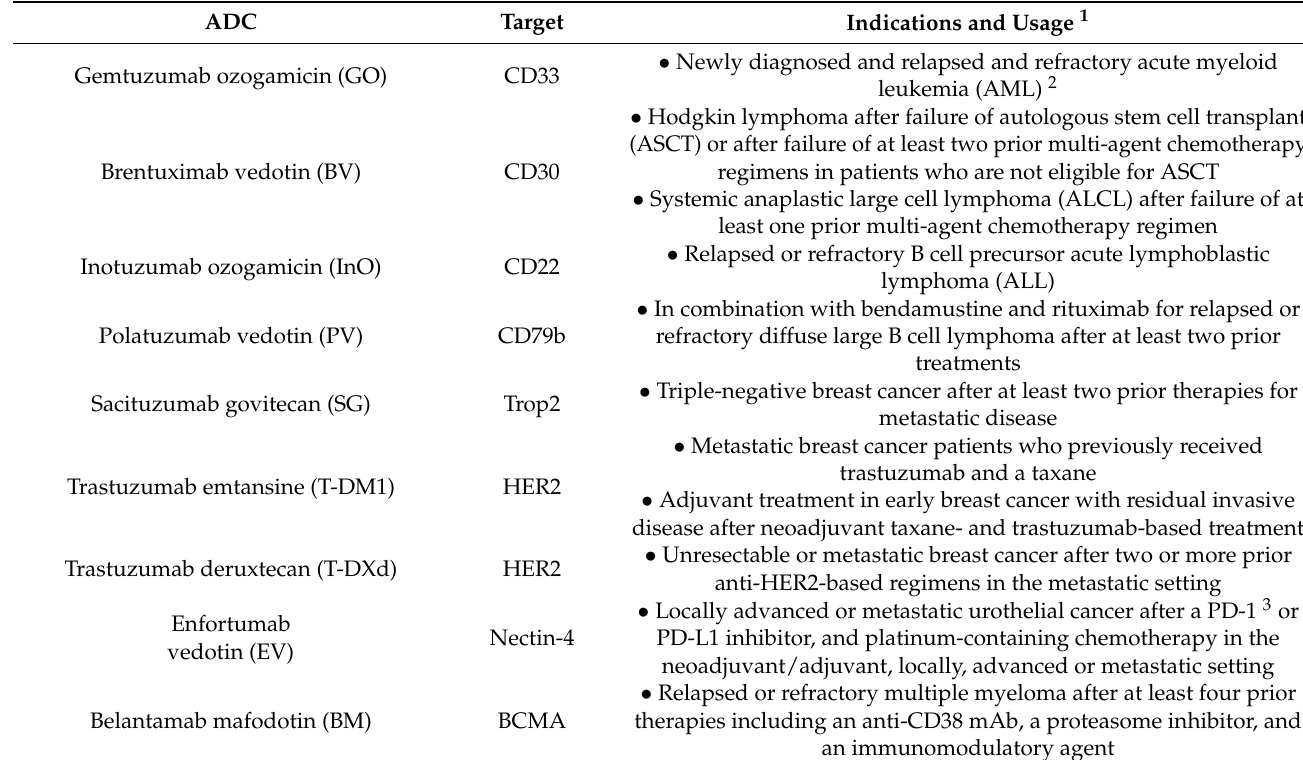
Table 1. Currently approved ADCs and